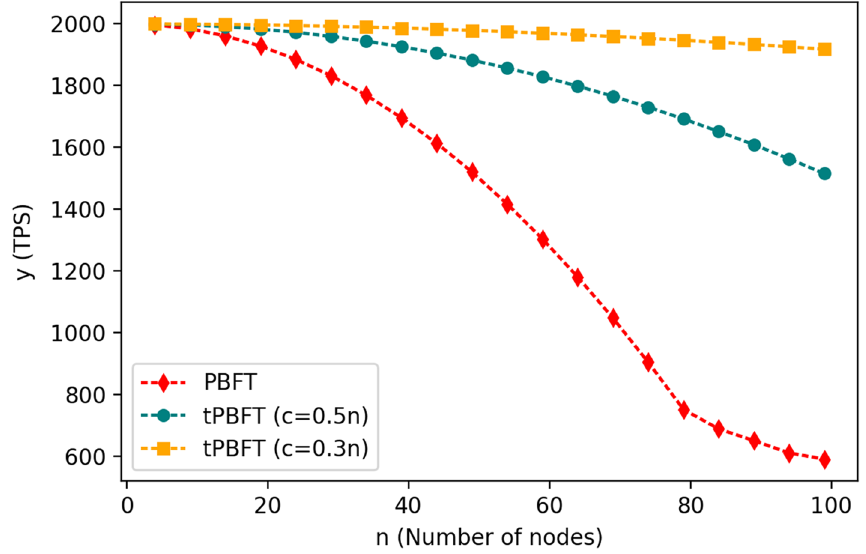
Figure 8. Comparison of TPS between tPBFT and PBFT